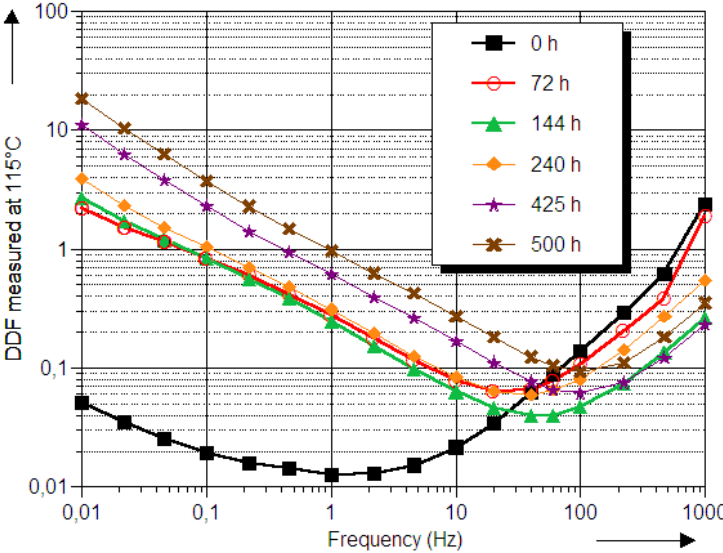
Figure 2. Effect of ageing on the DDF of oil impregnated pressboard samples measured at 115